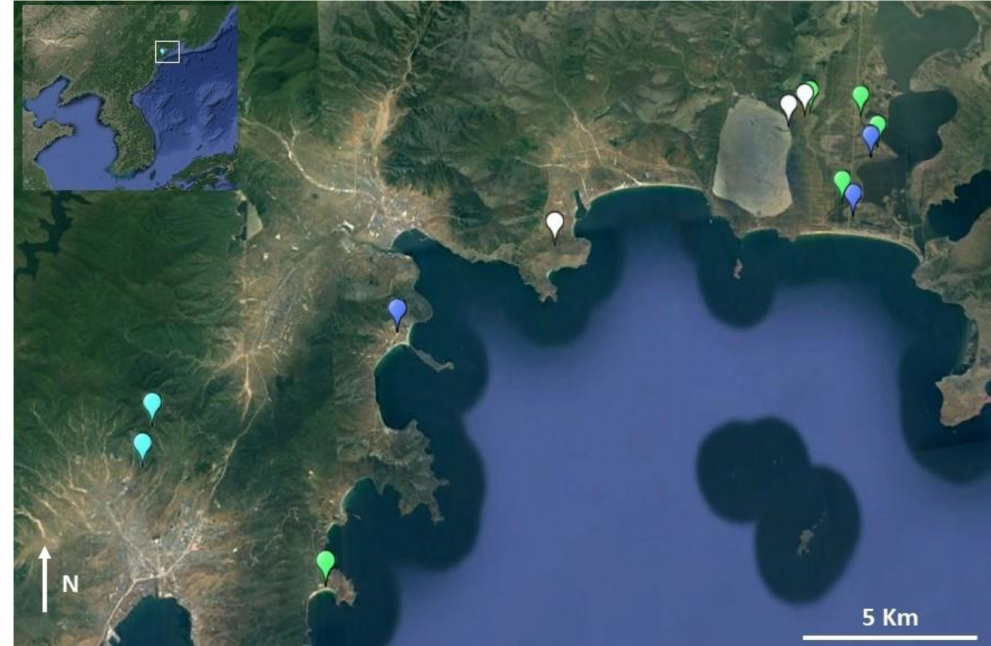
Figure 6. Location of the sampling sites in Rason, North Hamgyong, DPR Korea. Dark blue pins indicate agricultural wetlands, green pins indicate natural wetlands, white pins indicate grassy hills and light blue pins indicate mountainous areas. Satellite views extracted from Google Earth Pro (Google Earth Pro imagery, v7.1.2.2041; Mountain View, CA,